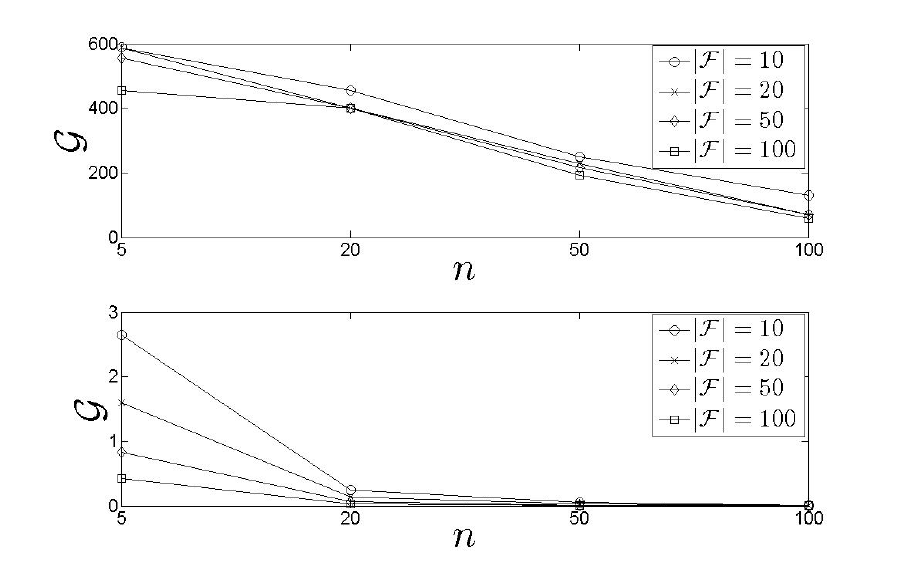
Figure 5. Our results for the throughput of the RLS and the CS